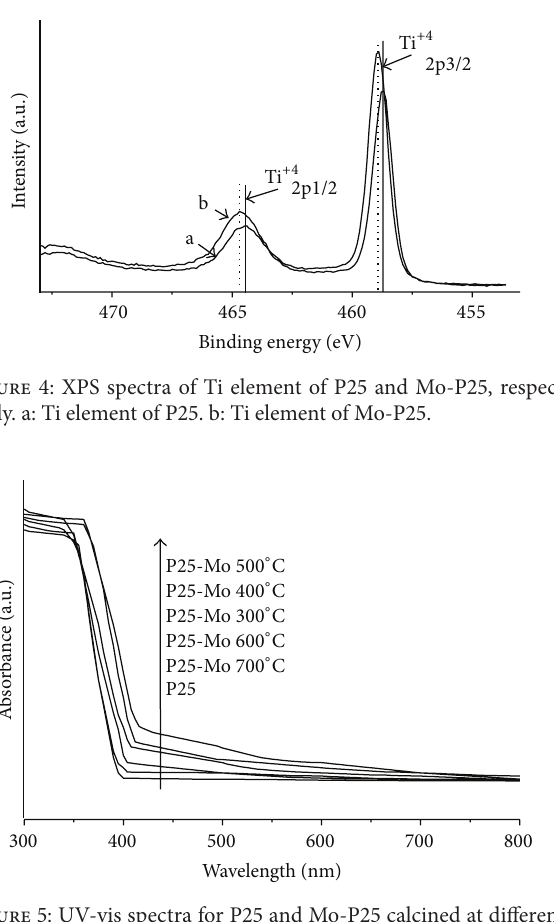
Figure 5: UV-vis spectra for P25 and Mo-P25 calcined at different